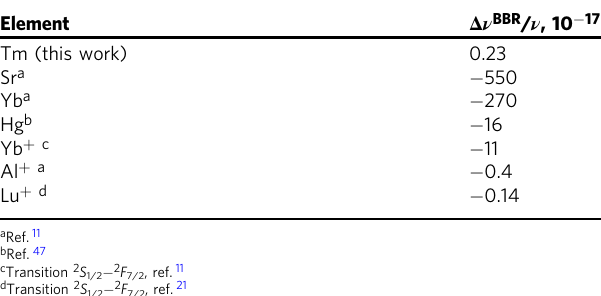
Table 1 BBR shitf comparison. Fractional BBR shift at 300